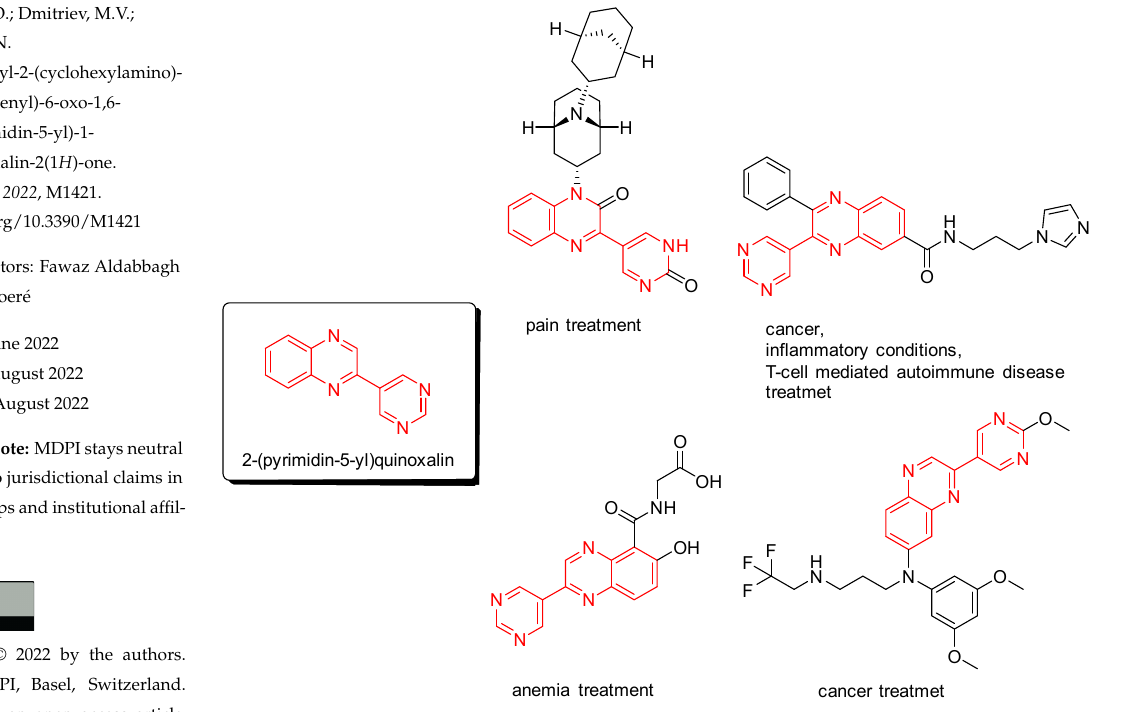
Figure 1. Potential pharmaceutical substances, bearing a 2-(pyrimidin-5-yl)quinoxaline core. As a continuation of our study on the syntheses of quinoxaline-based heterocycles A and B , via reactions of acyl(quinoxalin-2-yl)ketenes C , generated by the thermolysis